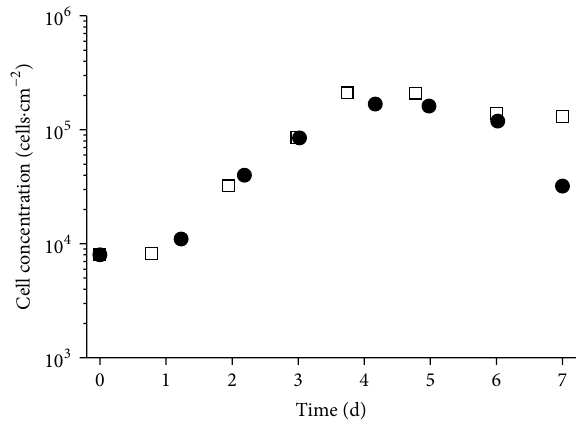
Figure 1: Growth kinetic of hUC MSCs from two different donors (HUC#255,female:whitesquares;HUC#256,male:blackcircles)in static 12-well culture plate in 1mL DMEM LG medium with seeding density of 8000 cells ⋅ cm −2